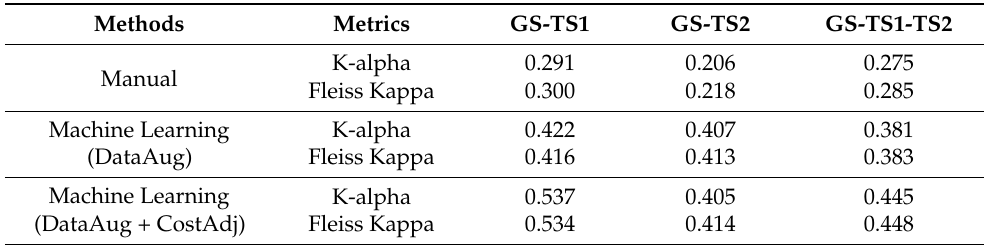
Table 3. The Krippendorff’s alpha (K-alpha) and Fleiss kappa of manual and machine learning